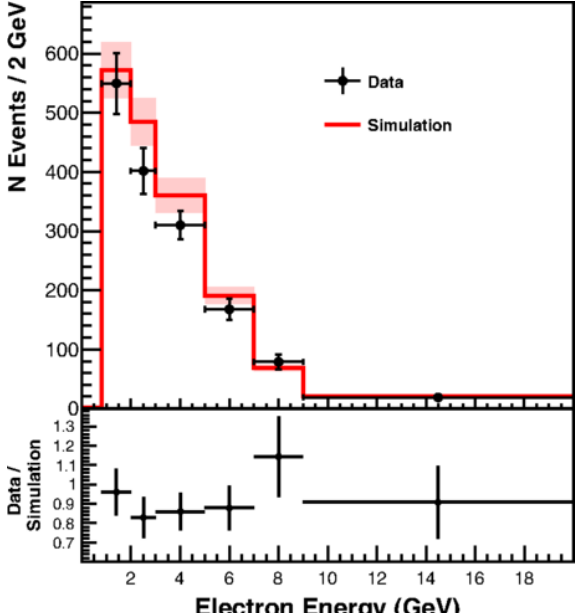
Figure 16. Reconstructed electron energy in ν µ e − ν µ e − after background subtraction and → efficiency correction in data and simulation (above) and the ratio of data to simulation (below). The error bars on the data include both statistical and systematic uncertainties. Reproduced under CCA4.0-I licence with permission from the American Physical Society